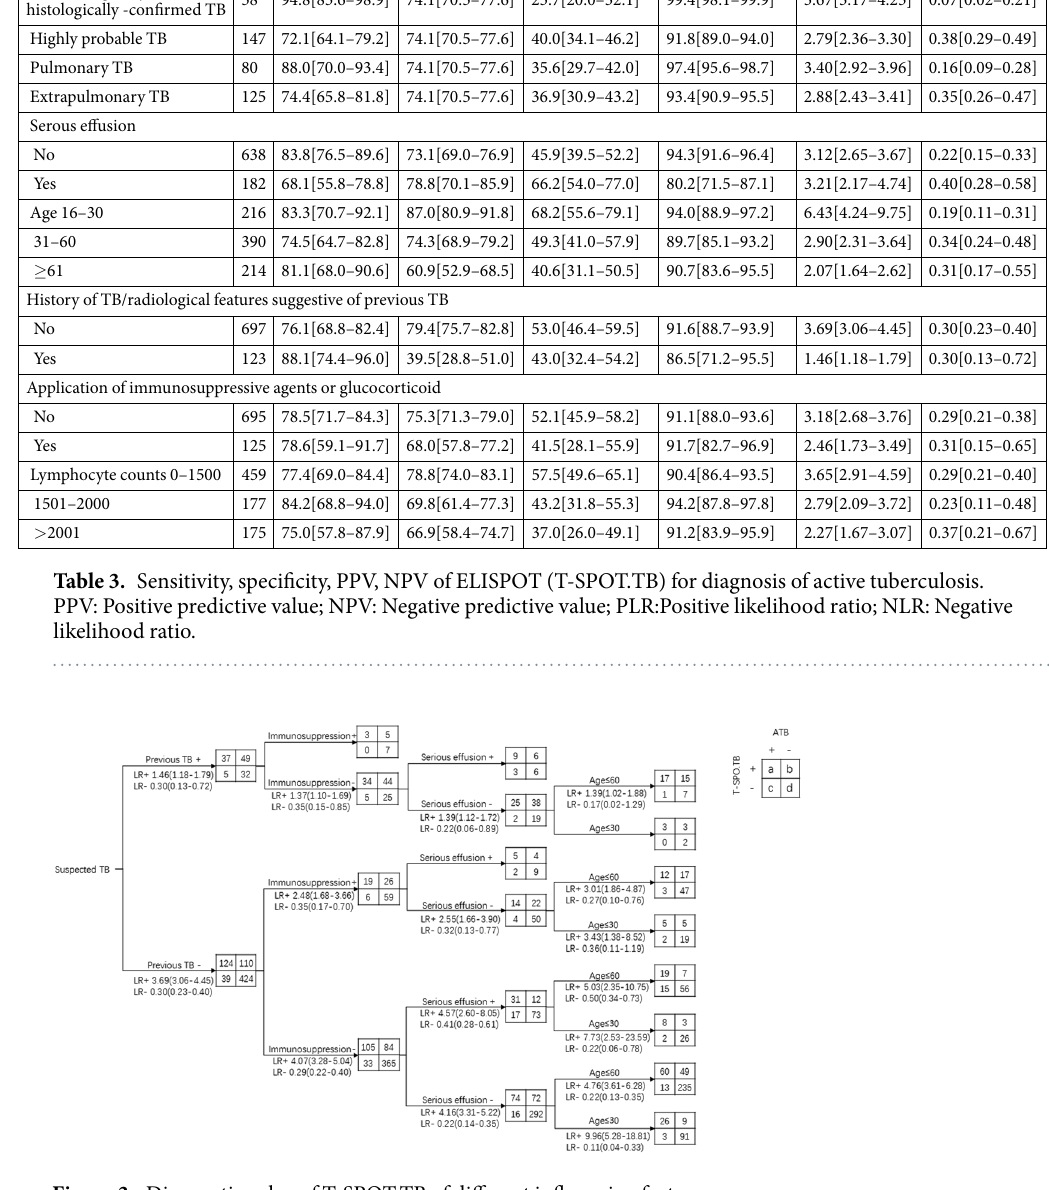
Figure 3. Diagnostic value of T-SPOT.TB of different influencing